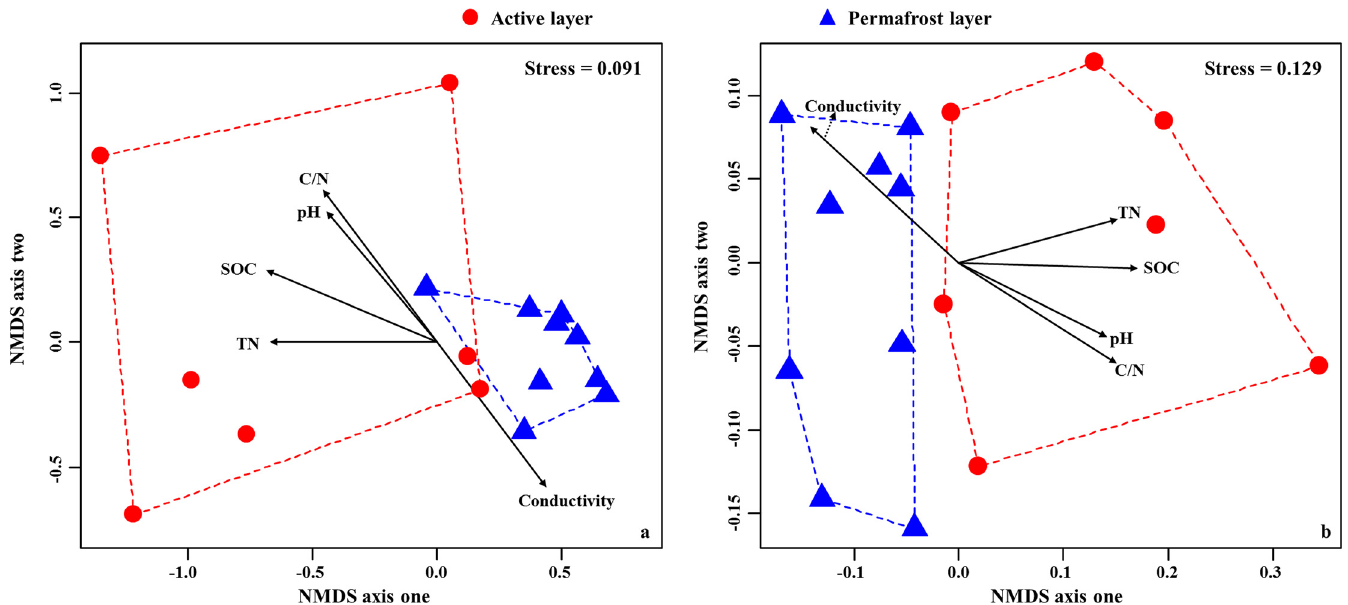
Fig 5. Non-metric multidimensional scaling (NMDS) plots of bacterial communities based on taxonomic dissimilarity (a) and betaMNTD (b) matrix, respectively. The stress value reflects how well the ordination summarizes the observed distances among samples (lower than 20% can be ecologically interpretable and useful). Soil variables were fitted as vectors onto each ordination plot, and significant vectors at 95% confidence level ( P (cid:3) 0.05) were